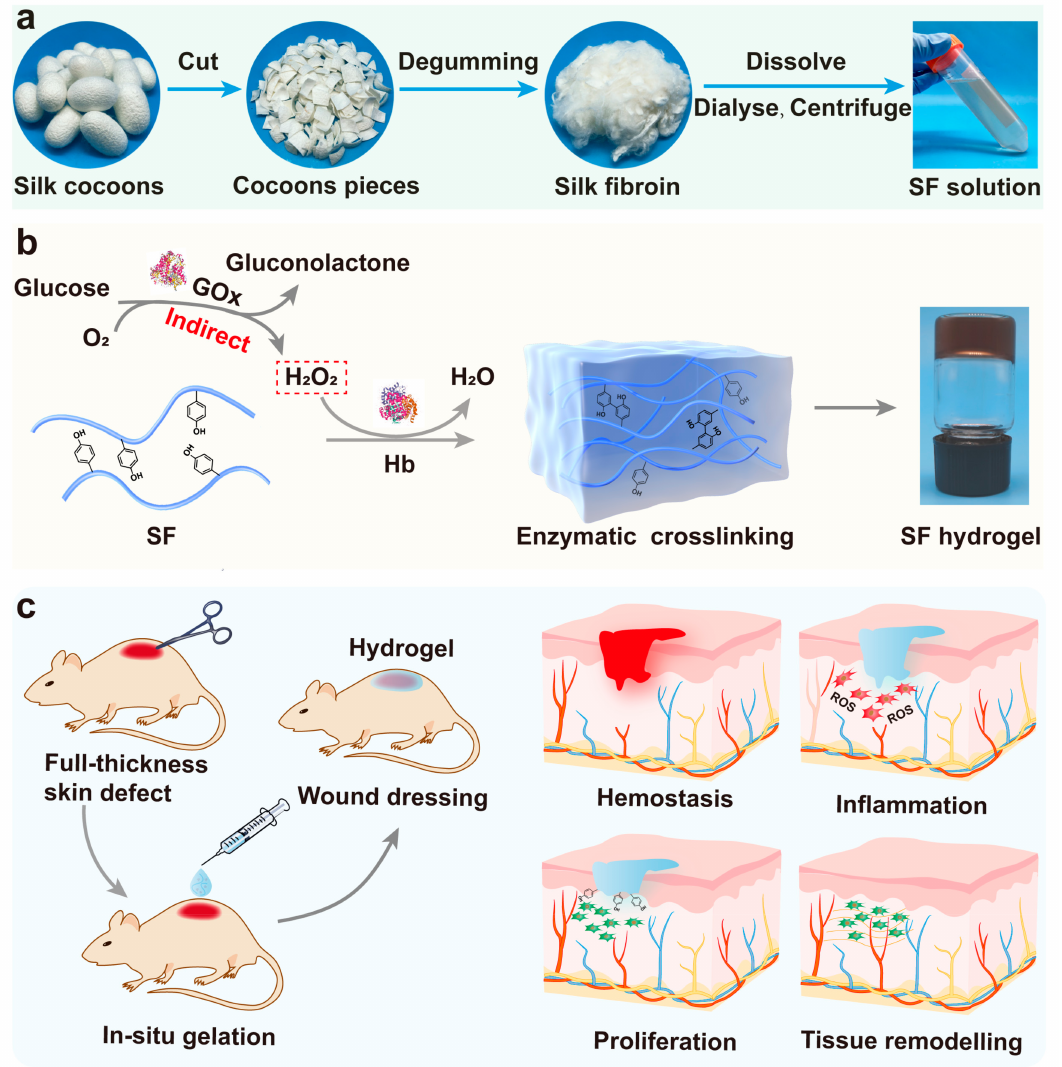
Figure 1. Schematic diagram illustrating silk fibroin (SF) hydrogel fabricated by enzymatic crosslinking for wound healing. ( a ) The extraction of SF solution by degumming, dissolving, and dialyzing from Bombyx mori cocoons. ( b ) Reaction mechanism of Hb-mediated covalent crosslinking between tyrosine residues on silk. ( c ) Application of SF hydrogels as wound dressings for skin wound